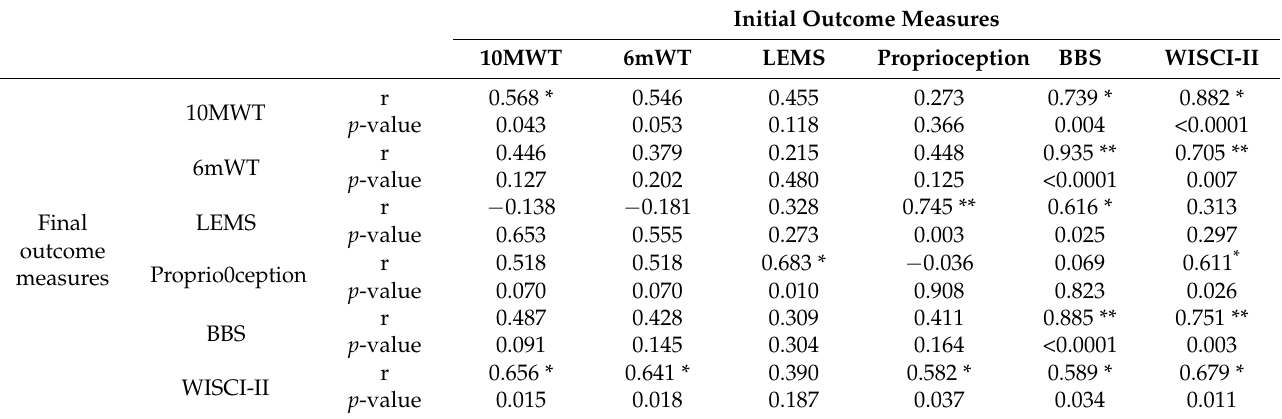
Table 5. Correlation final clinical outcomes with initial outcome